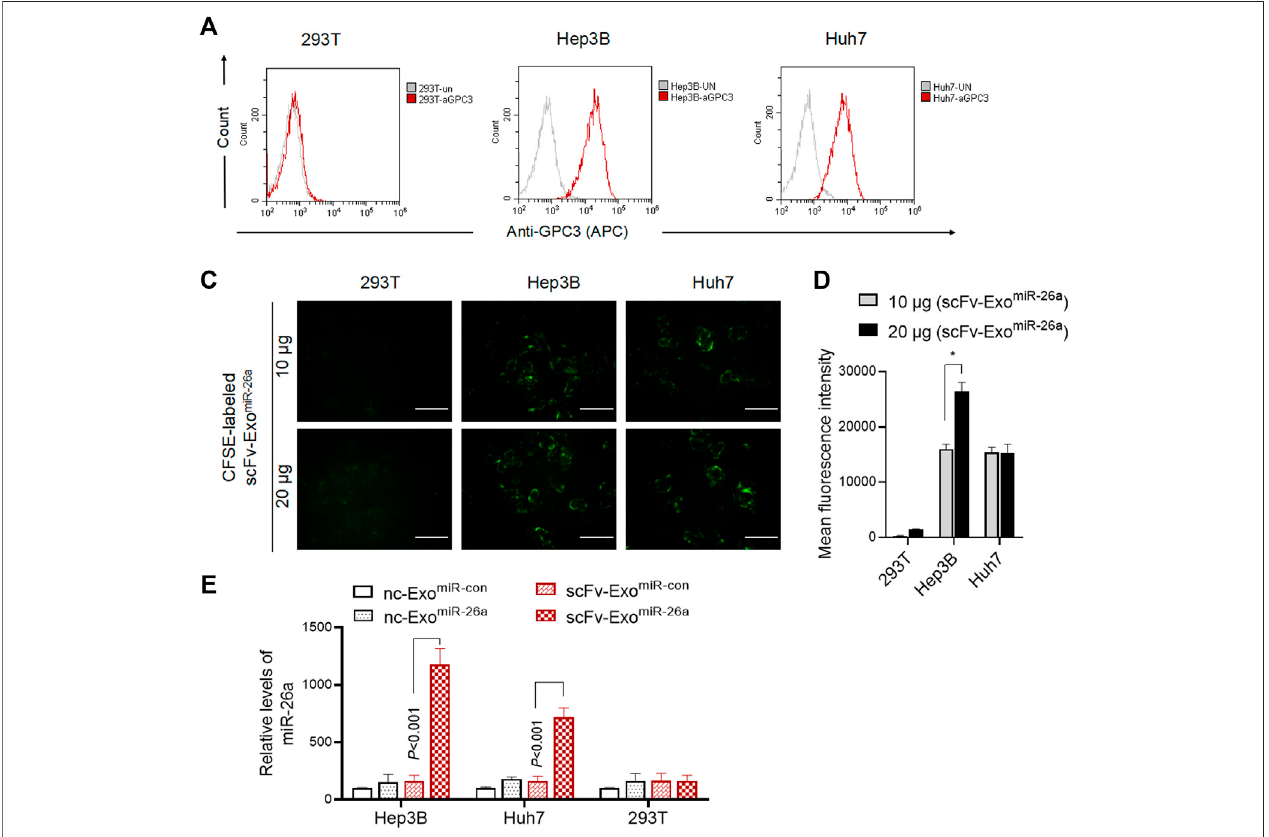
FIGURE 3 | Exosomes-based nanosystem effectively delivered miR-26a into HCC cells. (A) Flow cytometric detection of the expression of GPC3 antigen protein on the surface of 293T, HepG2 and Huh7 cells. (B) And the percentage of HCC cells expressing GPC3 was showed. *** p < 0.001 vs 293T. (C) CFSE-labeled scFv- Exo miR-26a (10 and 20 μ g) exosomes were added into 293T, HepG2 and Huh7 cells, and the green fl uorescence signals were observed and photographed after 6 h. Scale bars (cid:2) 50 μ m. (D) The fl uorescence intensity of CFSE was measured by fl ow cytometry. *** p < 0.001 vs 293T. (E) Detection of the abundance of miR-26a mimics in cells using quantitative real-time PCR